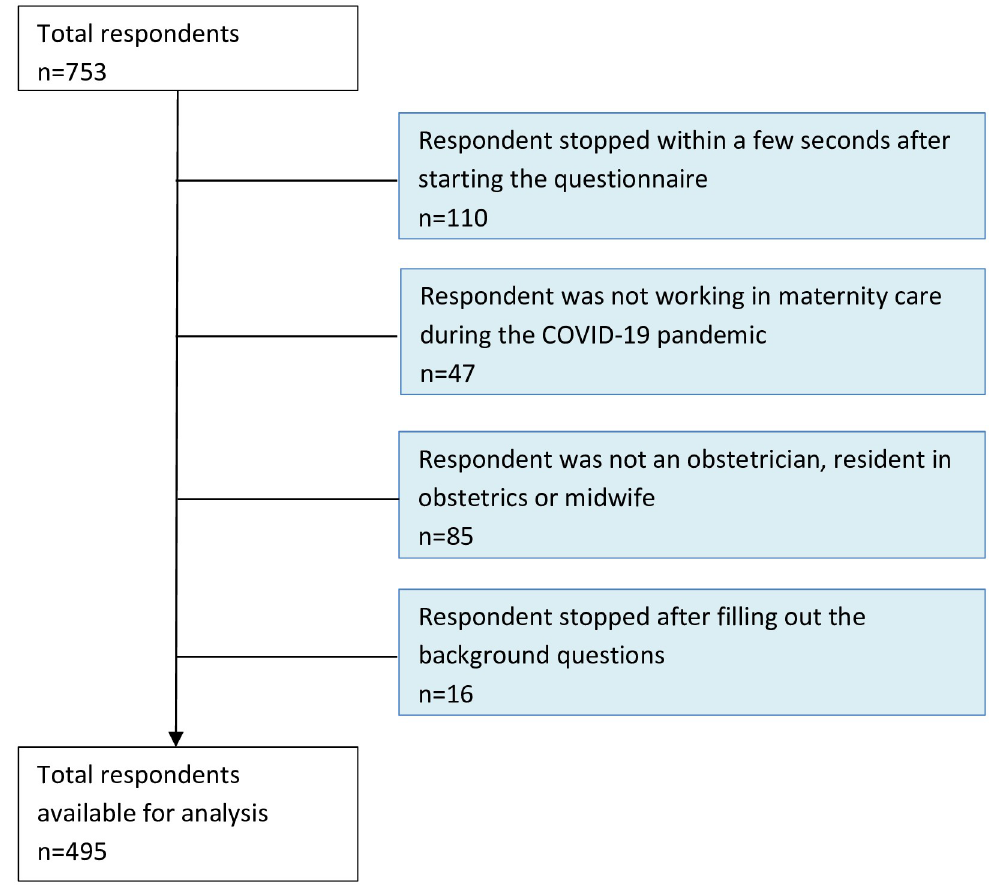
Fig 1. Flowchart of the study